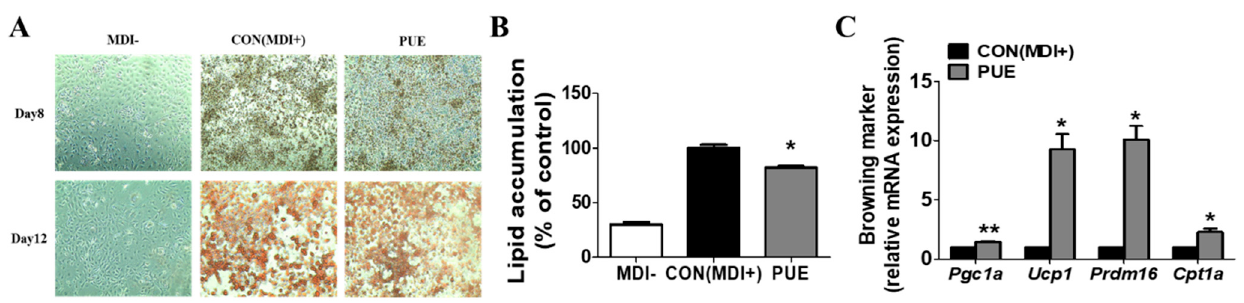
Figure 1. Effect of P. umbrosa root extract on lipid accumulation and browning-specific gene expression in 3T3-L1 adipocytes. ( A ) Oil red O staining (×200); ( B ) Lipid accumulation (%); ( C ) Browning-specific gene expression. ( B , C ) Data are presented as means ± SEM. Significant differences between CON (MDI+) and PUE are indicated by * p < 0.05; ** p < 0.01. MDI-, MDI-untreated cells; CON (MDI+), MDI-treated cells; PUE, MDI + P. umbrosa root extract, 100 μ g/mL. MDI, methylisobutylxan- thine, dexamethasone, and insulin; Pgc1a , Peroxisome proliferator-activated receptor gamma co- activator 1-alpha; Ucp1 , Uncoupling protein 1; Prdm16 , PR domain containing 16; Cpt1a , Carnitine palmitoyl-CoA transferase 1-alpha. 2.2. PUE Improved Body, Organ, and Adipose Tissue Weights by Regulating Lipid Metabolism The body weight of the high-fat diet (HFD) group animals was markedly higher from week 2 compared to that of the normal diet (ND) group, whereas that of the PUE group significantly decreased after week 9 compared to the HFD cohort (Figure 2A). The average daily body weight gain (BWG) for 12 weeks (g/day) in the PUE group was significantly lower than that in the HFD group (Figure 2B). There were no significant differences in food and energy intake between the HFD and PUE groups (Figure 2C,D). This led to a significantly lower food efficiency ratio (FER) in the PUE group than in the HFD group (Figure 2E). The liver weights of the HFD group were significantly higher than those of the ND animals, while those of the PUE group were significantly lower than that of the HFD group. In addition, kidney and muscle weights were significantly higher in the PUE group than in the HFD group (Figure 2F). The HFD group exhibited significantly in- creased adipose tissue weight and adipocyte size compared with the ND cohort. How- ever, PUE supplementation significantly decreased the perirenal, mesenteric, subcutane- ous, and interscapular WAT and BAT weights and adipocyte size. WAT collagen accu- mulation was assessed by Masson’s trichrome (MT) staining, and fibrosis (stained blue) clearly progressed in the HFD group, but not in the ND and PUE groups (Figure 2G,H). Plasma adiponectin levels were significantly higher in the PUE group than in the HFD group. The plasma leptin, resistin, and leptin: adiponectin (L:A) ratio values in the HFD group were significantly increased compared to those in the ND group; their values in the PUE supplementation group were markedly lower than those in the HFD group (Figure 2I). The mRNA expression of Lipe in epiWAT was markedly increased in the ND and PUE groups compared to that in the HFD group. In addition, PUE significantly upregulated the mRNA expression of thermogenic genes such as Ucp1 in epiWAT (Figure 2J).